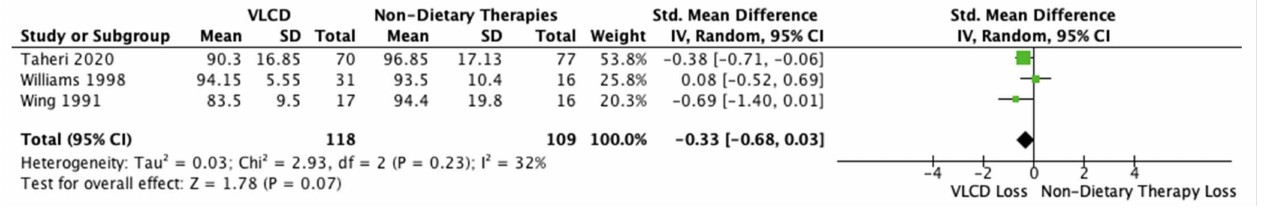
Figure 8. Forest plot comparing the reduction in body weight between VLCD and non-dietary therapies [22,49,50].